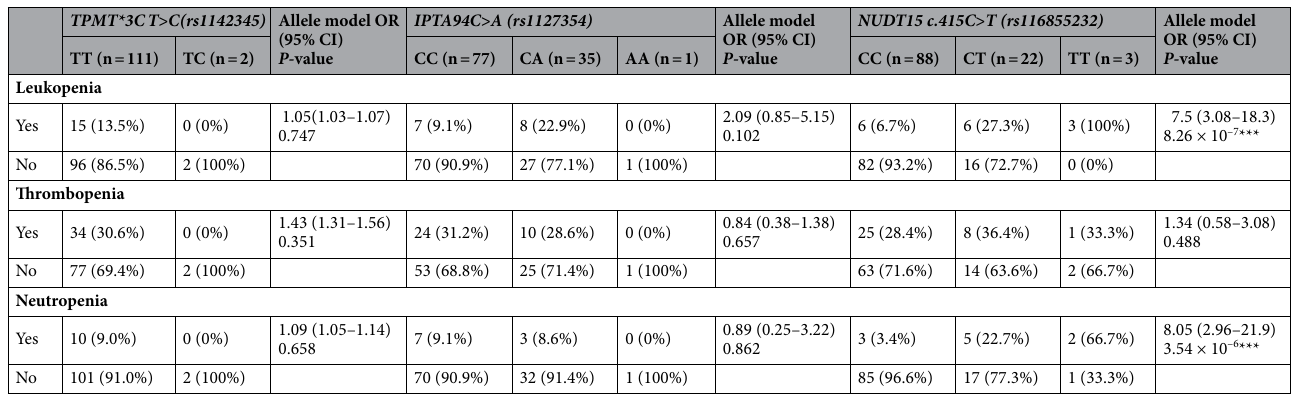
Table 4. Association of myelosuppression with NUDT15 c.415C > T, ITPA 94C > A and TPMT*3C genotypes. CI confidence interval. ***Significant ( P <